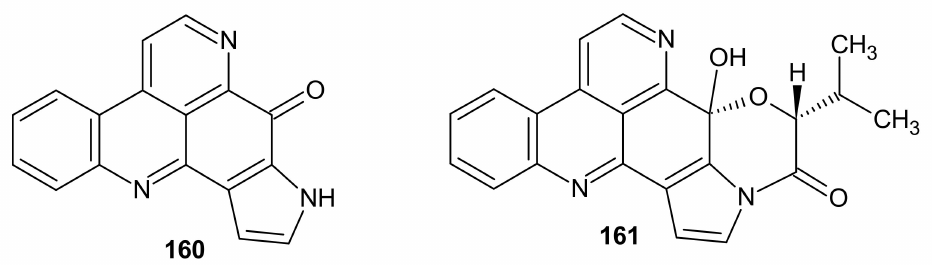
Figure 41. Sebastianine A 160 and B 161 .